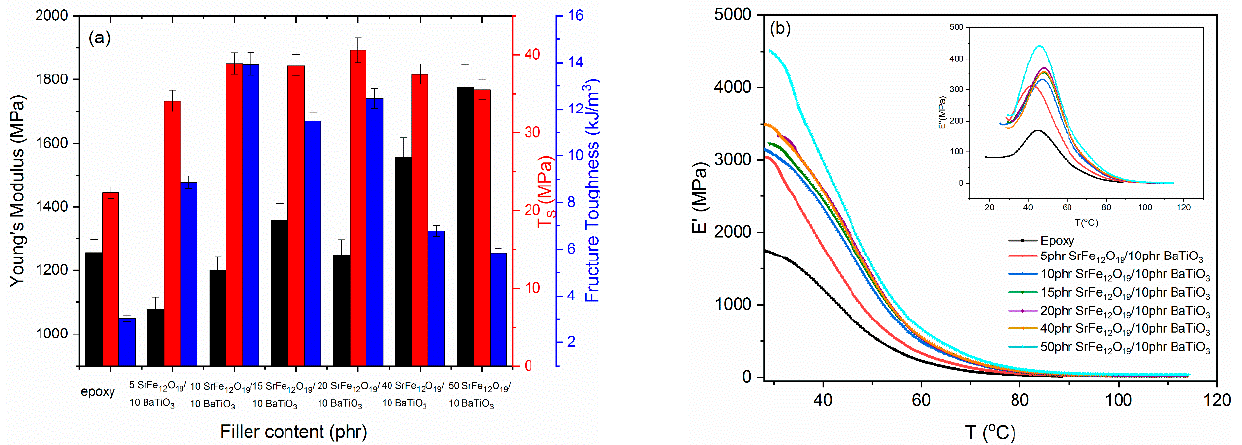
Figure 13. ( a ) Young’s modulus, tensile strength, and fracture toughness for all studied systems versus filler content. ( b ) Storage modulus and loss modulus (inset) as a function of temperature for all studied systems.